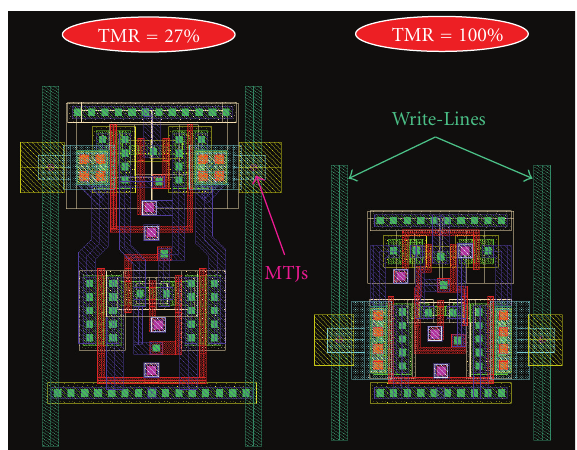
Figure 18: Implemented layout of the second TAS-MRAM cells (shown in Figure 6) validated for a TMR of 27 and 100%.